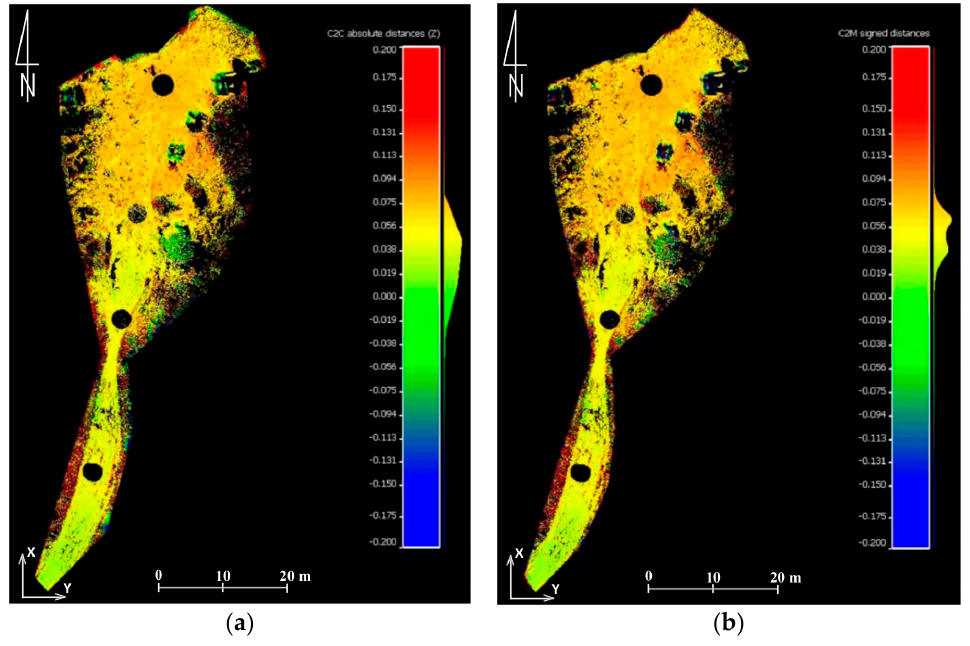
Figure 9. Results of comparing the point cloud from TLS with the point cloud from the UAV ( a ) and mesh model from the UAV ( b ) in certain points for the first test field (source: authors’ own study) (the units given are in m).